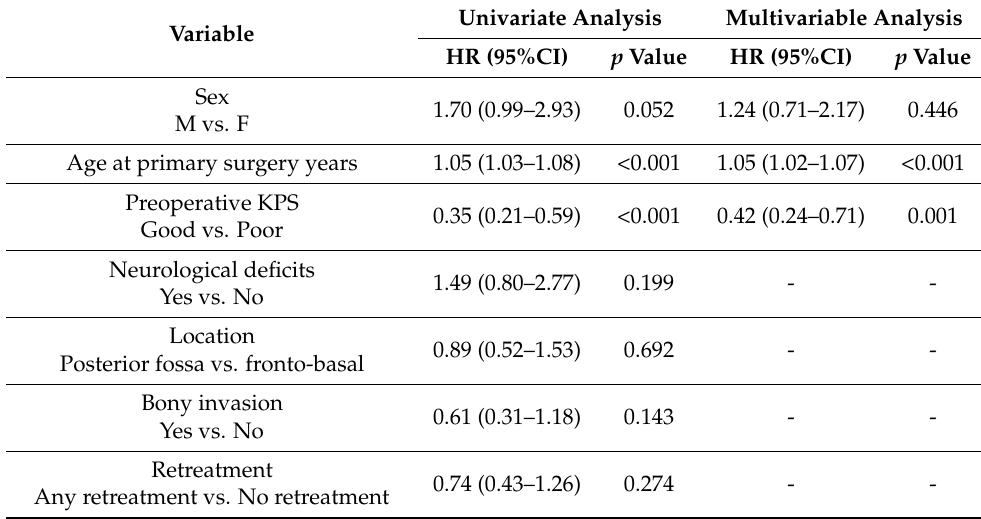
Table 3. Univariate and multivariable Cox model for overall